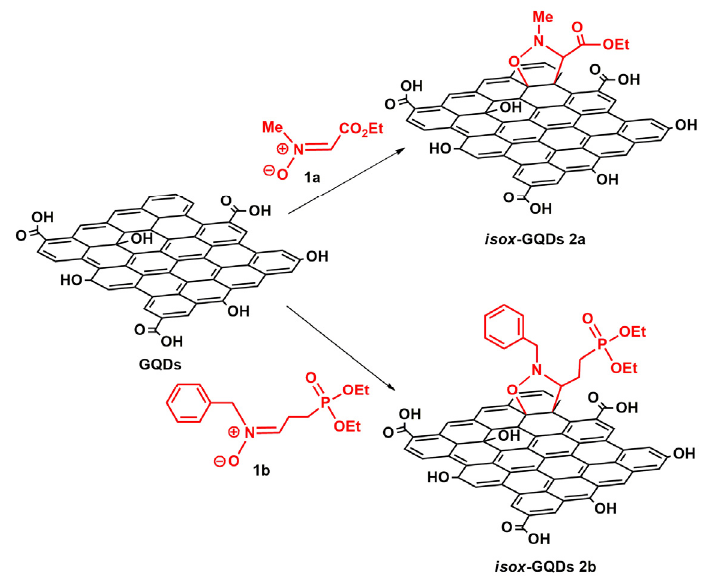
Scheme 1. Synthesis of cycloadducts isox -GQDs 2a and isox -GQDs 2b . Reagents and conditions: